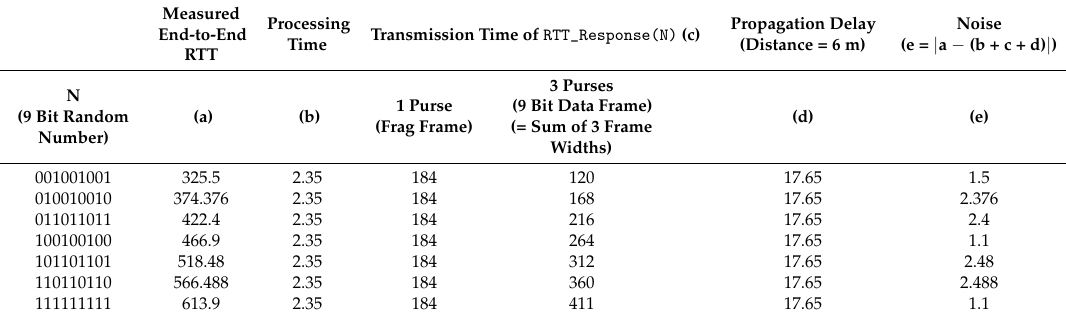
Table 2. Measured round trip time (ms) of RTT_Challenge(N) and RTT_Response(N) messages when distance = 6